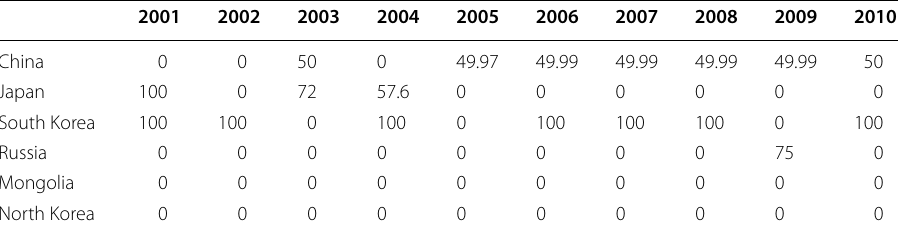
Table 3 Contributions to the Core Fund of the NEASPEC (in thousand US $). Source : NEAS- PEC Senior Officials Meeting (SOM) reports, SOM